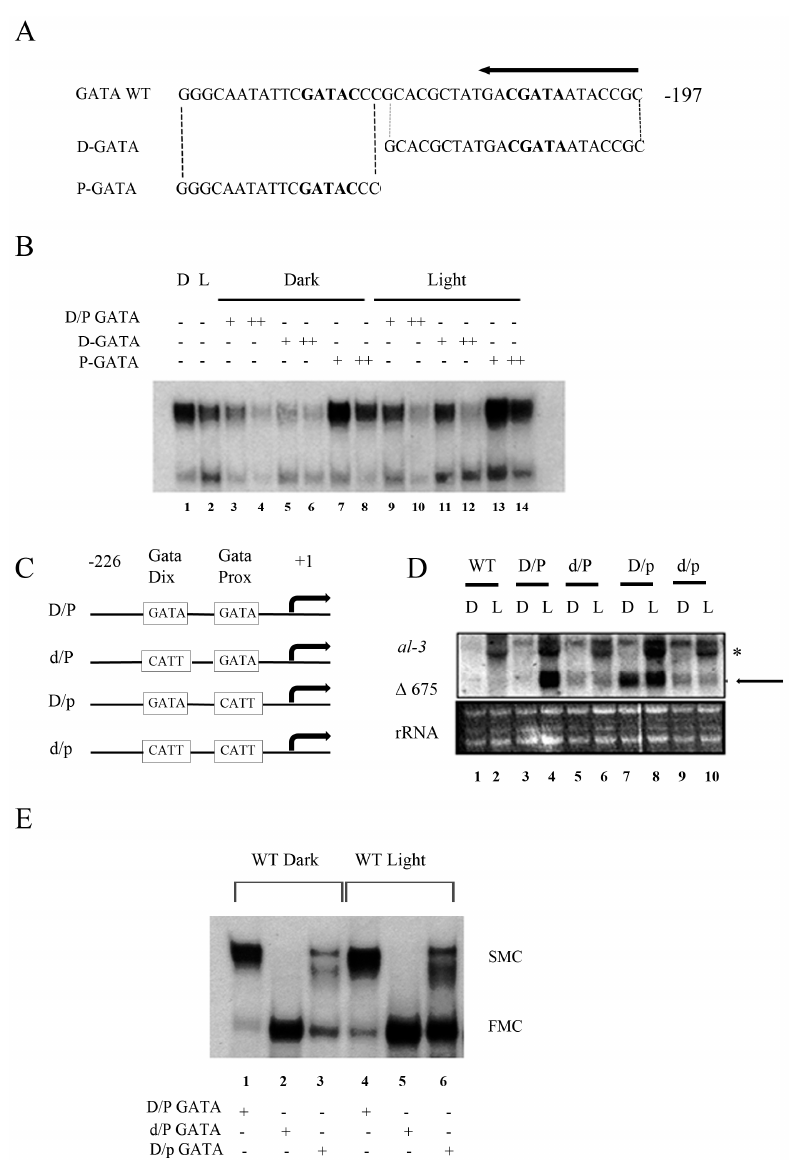
Figure 2. Role of proximal and distal GATA sequences in dark / light shift. ( A ) Schematic representation of al-3 promoter GATA region that was used for the EMSA. The arrow indicates the direction towards the transcriptional start site. ( B ) EMSA was performed on N. crassa nuclear extracts of mycelia grown in the dark or after light pulse and incubated with the al-3 promoter GATA regions as the probe (lanes 1–2). Competition assay was performed by co-incubating labelled GATA with increasing concentrations (+ = 10-fold, ++ = 50-fold) of each indicated cold competitor sequence (lanes 3–4, 9–10: D / P GATA; lanes 4–5, 11–12: D-GATA; lanes 6–7, 13–14: D-GATA). ( C ) A diagrammatic representation of the exogenous al-3 promoter bearing mutations of the GATA motifs. ( D ) Representative Northern blot analyses of Neurospora transformants containing a shortened version of the al-3 gene. Asterisk: endogenous al-3 expression. Arrow: ∆ 675. ( E ) EMSA was performed using the nuclear extract of wt N. crassa mycelia grown in the dark (lanes 1–3) or light-treated for 20 min (4–6). Competition experiment was performed by adding cold probes as indicated in the